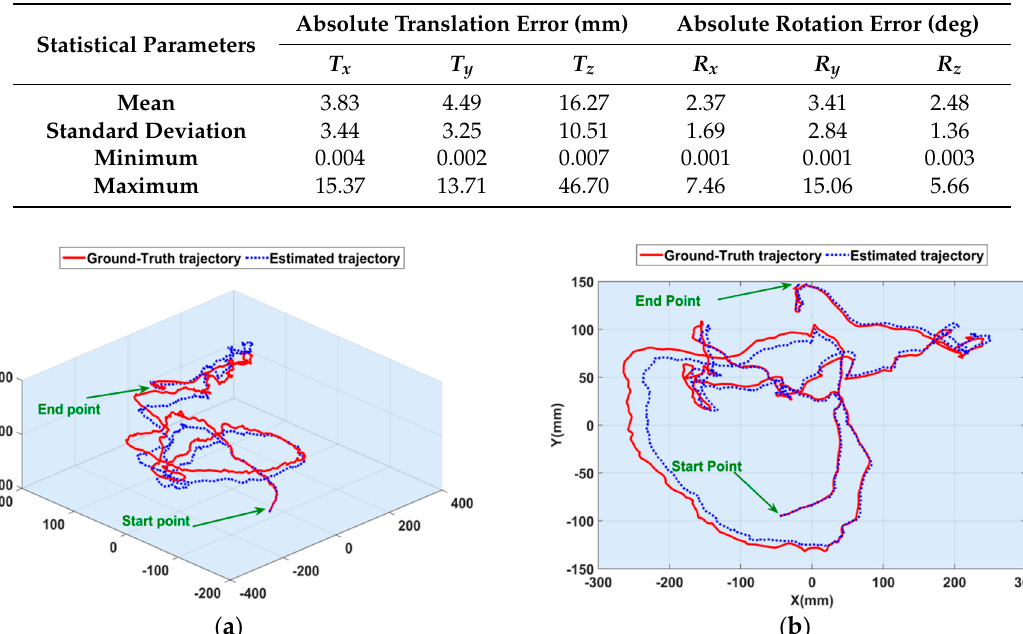
Figure 4. Feature tracking until initialization: ( a ) Active features + newly detected features; ( b ) active features + tracking path of new features + initialization point of new features. Table 1. Absolute translation and rotation errors.